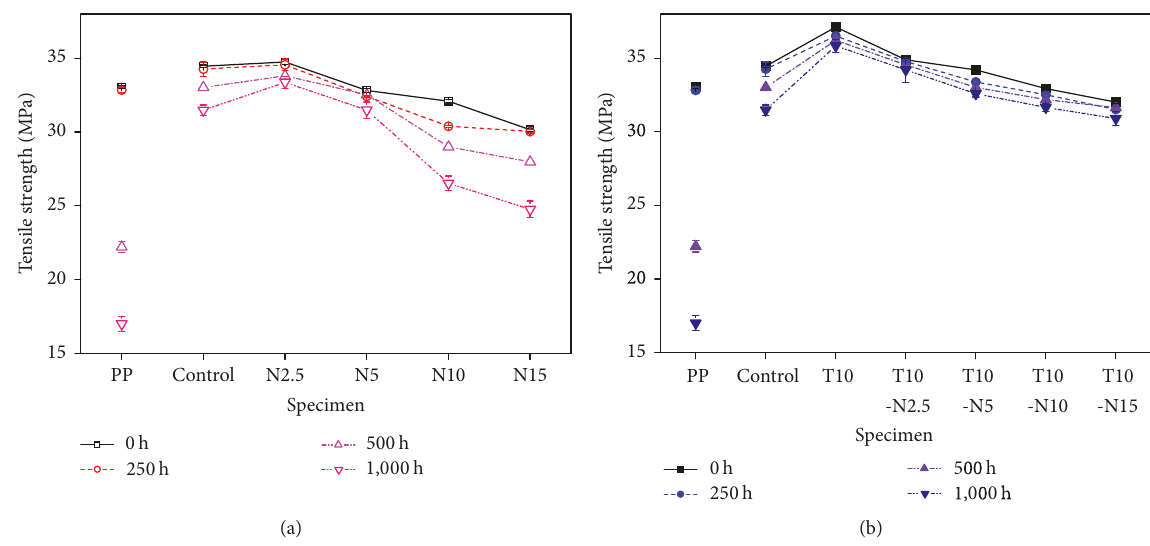
Figure 2: Tensile strength of pure PP, control, PP-based composites depending on accelerated weathering time: (a) NCC-only; (b) NCC-Talc.